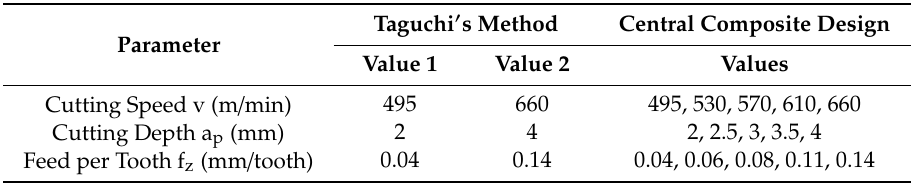
Table 5. Cutting regime parameters and their values for Taguchi (cid:48) s method and central composite